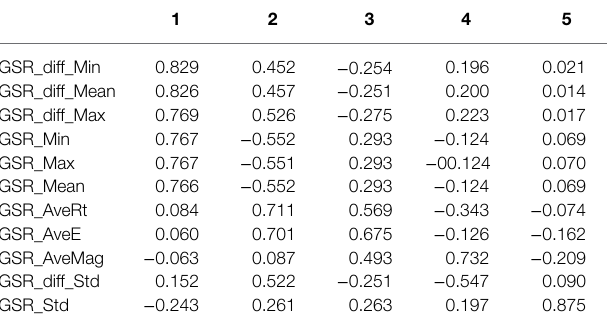
TABLE 5 | Results of principal component